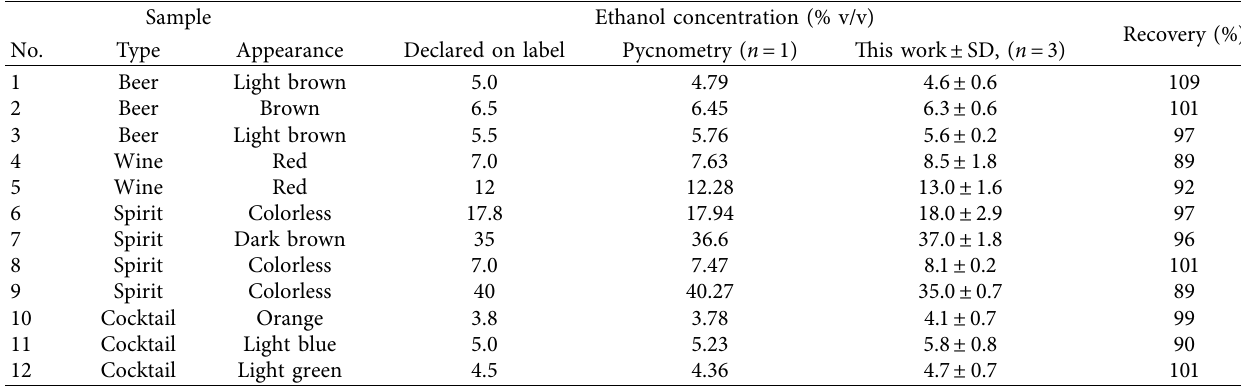
Table 3: Ethanol concentrations and their recoveries in beverage samples by the proposed MBL-VP unit in comparison with the con- ventional method. Sample Ethanol concentration (% v/v)